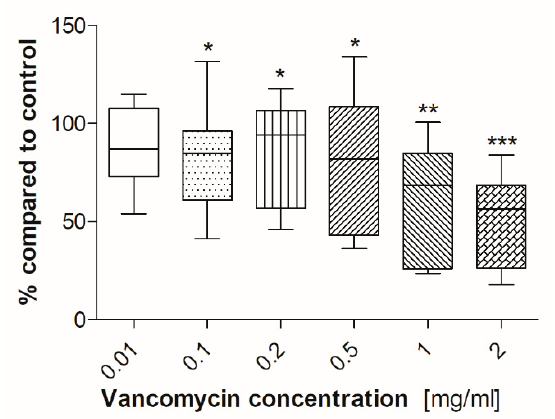
Figure 10. Myotube formation of human muscle cells after exposure to vancomycin (* p < 0.05; ** p < 0.01; *** p < 0.001 to control). The results are presented in percentage of the control without vancomycin (100%).